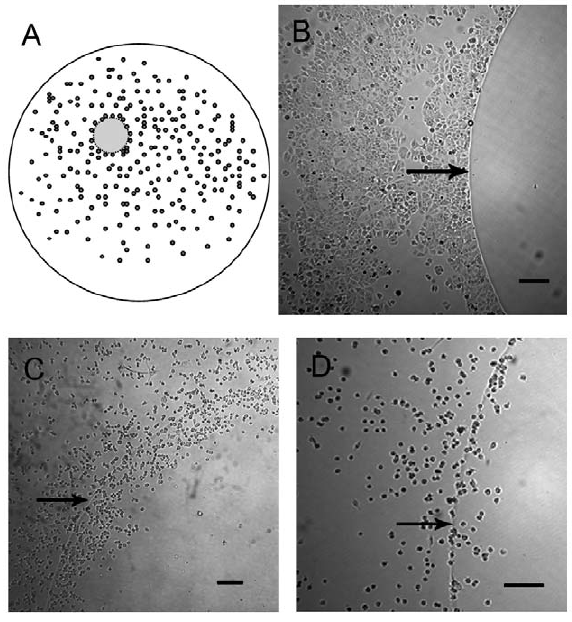
Figure 5. Agarose spot assay. Panel A is a cartoon to illustrate agarose spot inside well with cells added some of which settle around the periphery. MCF7 (B) and pII (C, D) cells were plated into individual wells of a 12 well dish containing an agarose spot, and photographed after 24 h of incubation. MCF7 cannot penetrate even at high density whereas pII do so even at very low density (D). Arrows delineate the periphery of the agarose spot beneath. Scale bar represents 400 m m. This experiment was repeated at least ten times with identical outcome. The numbers of pII cells entering the agarose varied with density of cells settling at the periphery, and time.